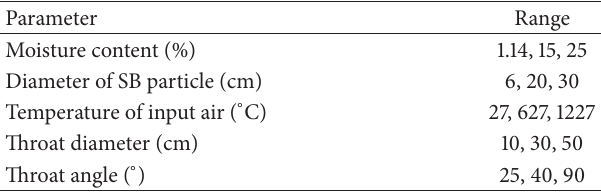
Table 4: Parameters varied during gasification simulation.